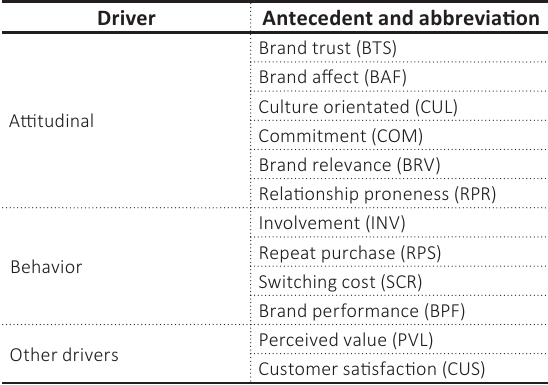
Table 1. Classification of antecedents (Jacoby & Chestnut, 1978; Aaker, 1996; Fischer, Völckner, & Sattler,